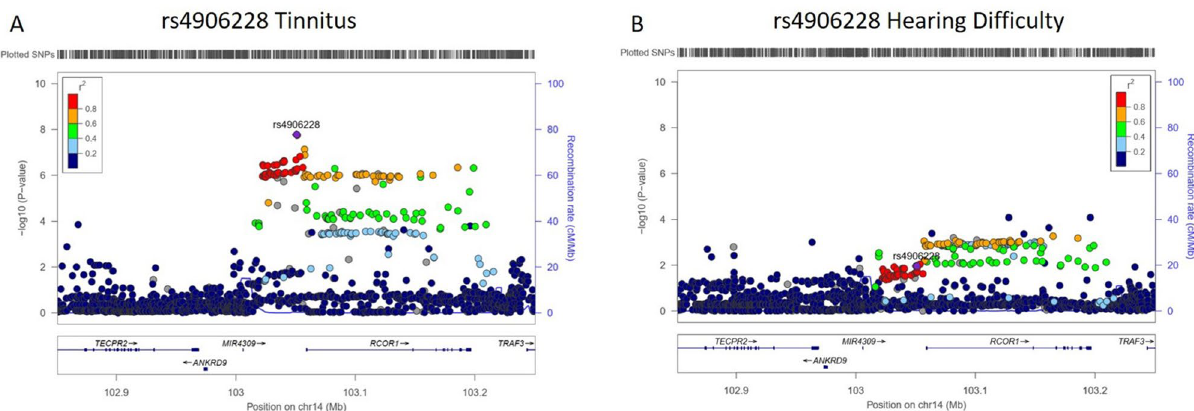
Figure 2. Locus Plots for rs4906228 association with tinnitus and hearing difficulty in UKBB. ( A ) Locus plot for lead SNP at genome-wide significance on Chr14, rs4906228 in genetic association analysis with frequency of tinnitus symptoms. Purple indicates lead independent SNP generated from GCTA-COJO conditional analysis. The colouring of remaining SNPs is based on the linkage disequilibrium (r2) with the leads. Where LD information is not available, SNPs are coloured grey. The genes within the region are annotated and the direction of transcription is indicated by arrows. ( B ) Same plot is shown for association of rs4906228 with self- reported hearing difficulty as described previously 22